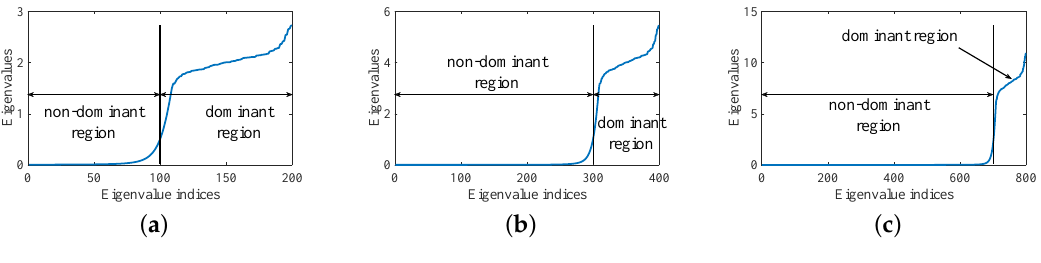
Figure 4. Eigenvalues of LFM radar signal. ( a ) N = 100, M c = 2 ( b ) N = 100, M c = 4 ( c ) N = 100, M c =